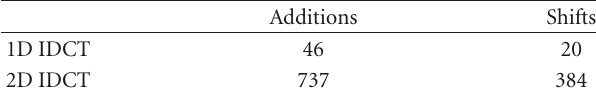
Table 5: Computational complexities of 1D and 2D